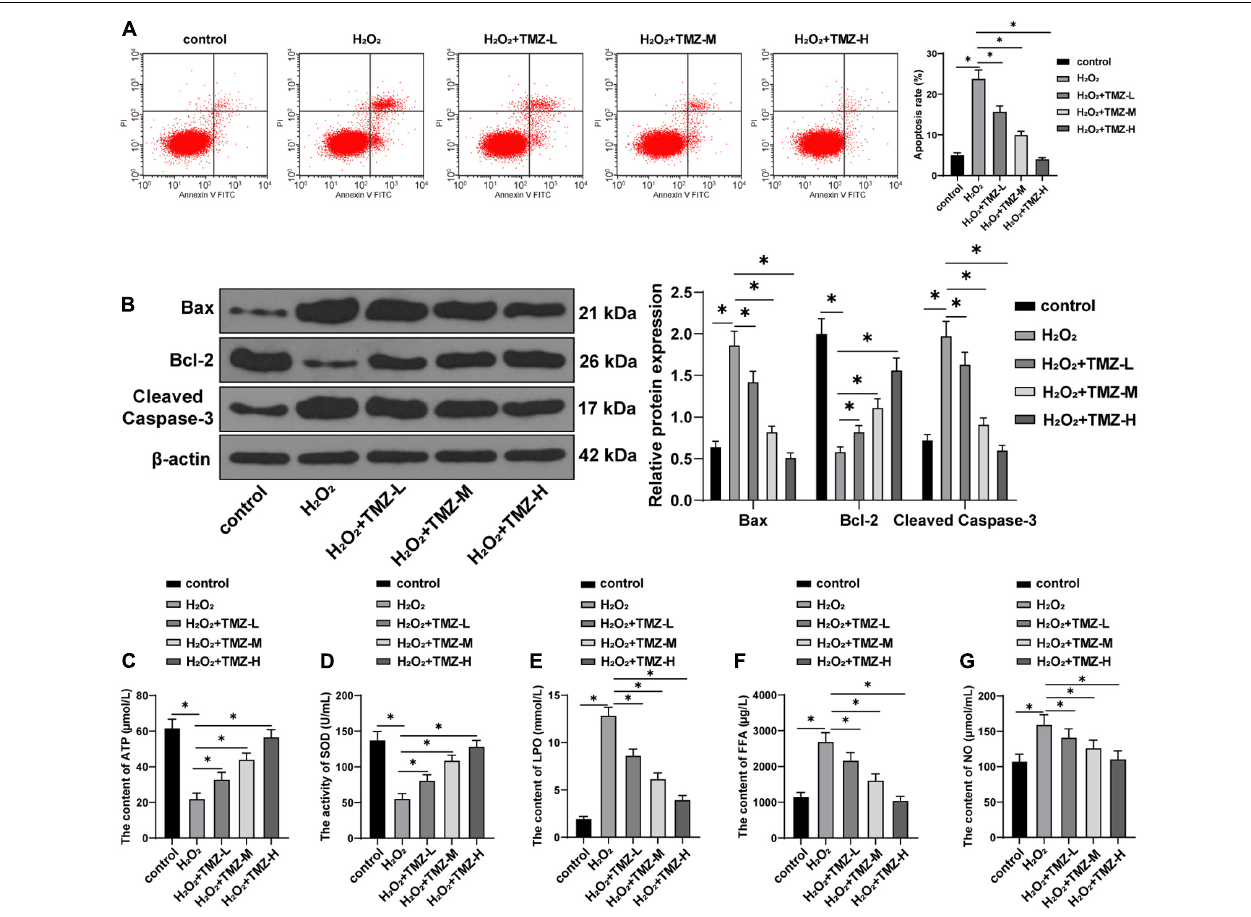
FIGURE 3 | Trimetazidine inhibited H 2 O 2 -induced cardiomyocyte apoptosis and energy metabolism disorder. (A) Flow cytometry analysis for apoptosis. (B) Western blot analysis of Bax, Bcl-2, and cleaved caspase-3 expressions. (C) ATP content in H9C2 cardiomyocytes. (D) SOD activity in H9C2 cardiomyocytes. (E–G) Contents of LPO in panel (E) , FFA in panel (F) , and NO in panel (G) in H9C2 cardiomyocytes. Cell experiment was repeated three times. All data were expressed as the mean ± standard deviation. Data were analyzed using one-way ANOVA, followed by Tukey’s multiple comparisons test. * P < 0.05. ATP, adenosine